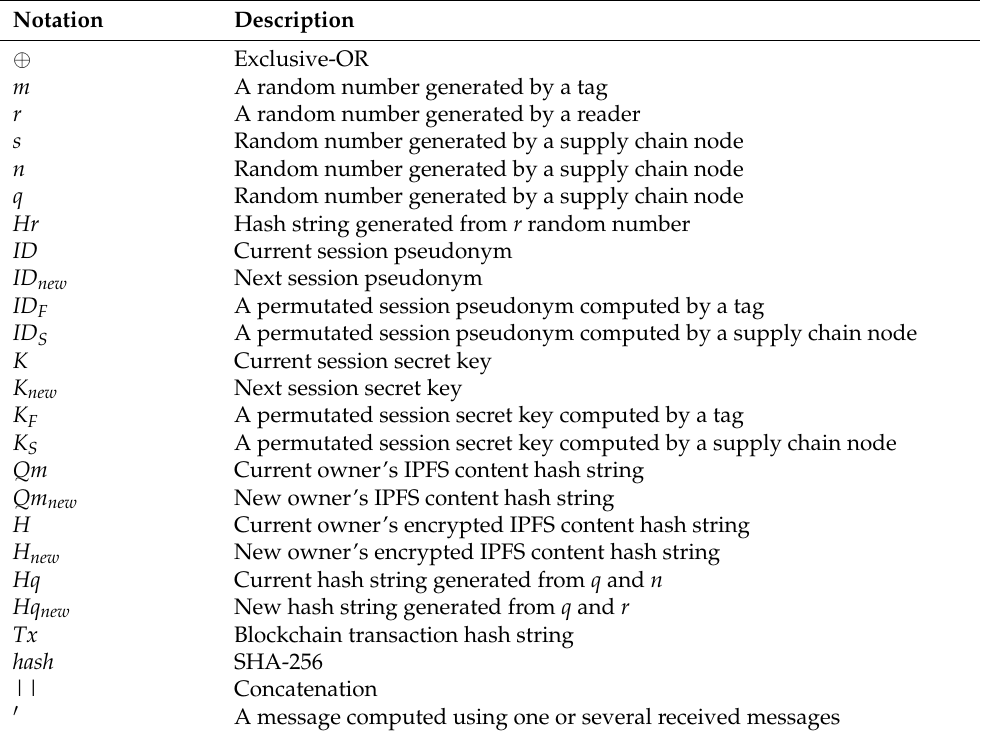
Table 4. Notations used in the proposed